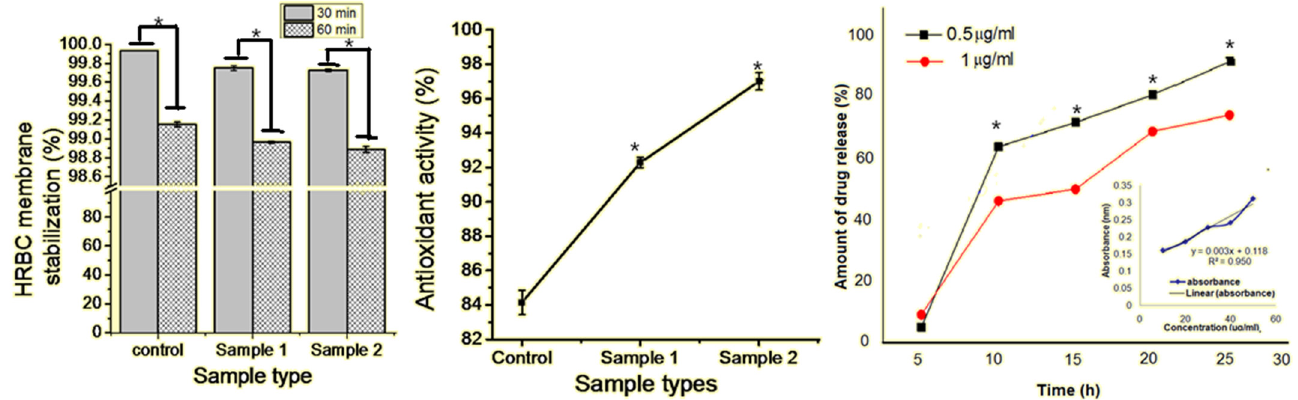
Figure 3. Anti-inflammatory, anti-oxidative, and drug-release profile of the quercetin-loaded gelatin–alginate polymeric beads. Here * indicated the significant difference between the samples at p ≥ 0.05.